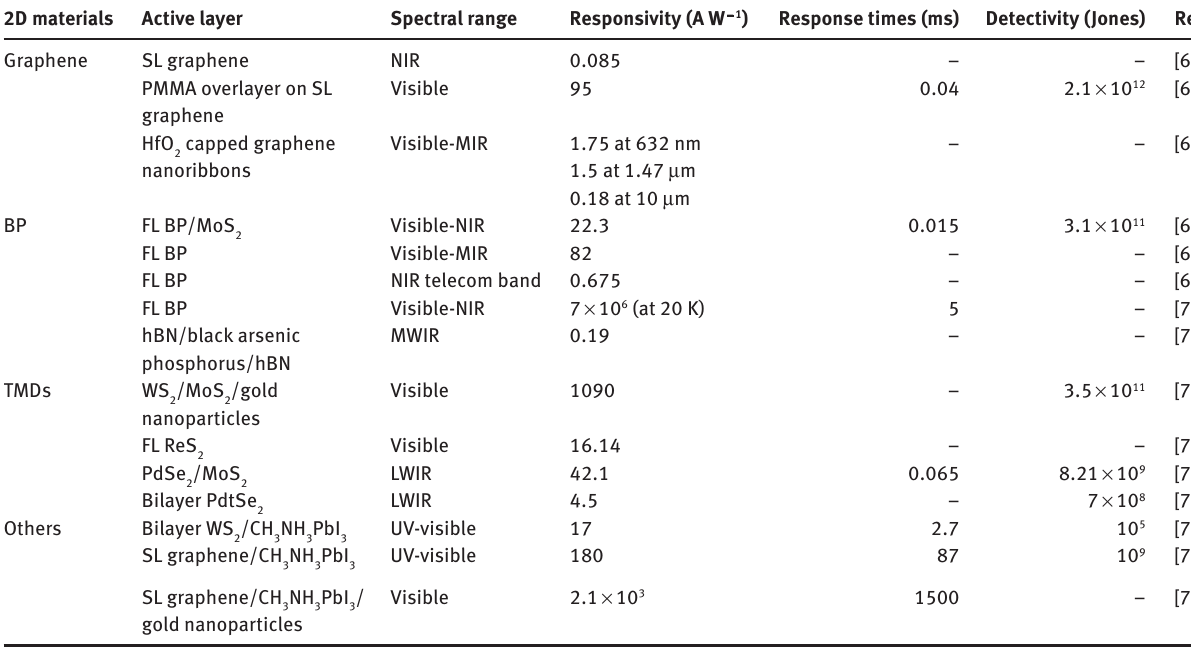
Table 1: 2D materials-based photodetectors with key